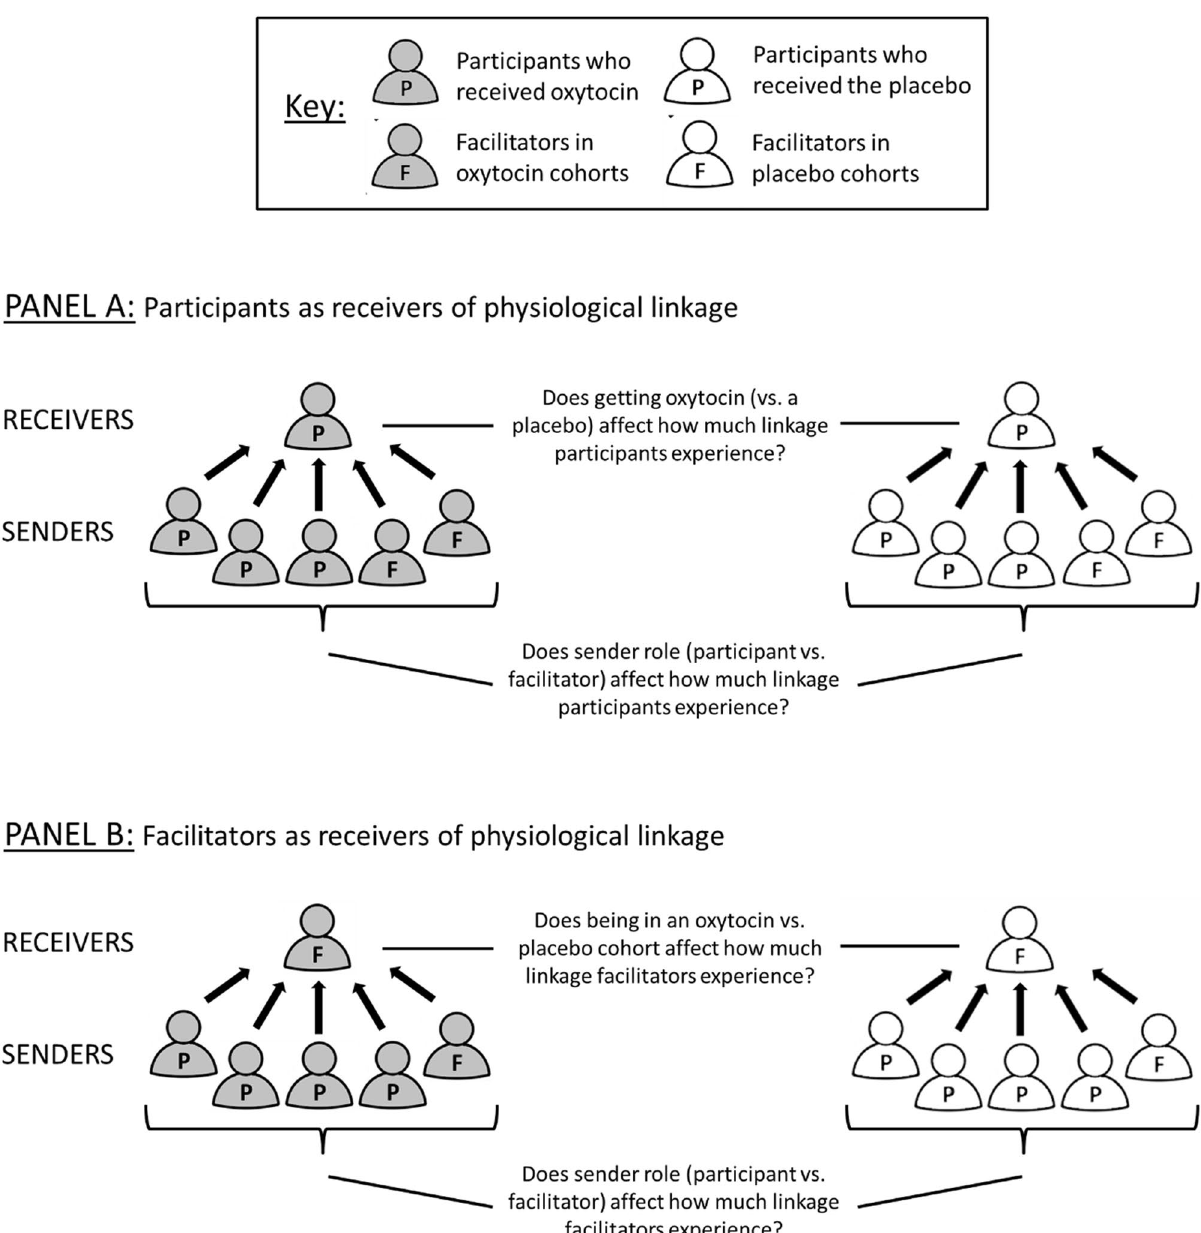
Figure 3. Models of physiological linkage. Arrows indicate potential physiological linkage from senders to receivers: senders’ physiological responses predict the physiological responses of receivers at a following time interval. ( A ) We examine how much participants are receivers of physiological linkage (i.e., how much other people’s physiological responses predict participants’ physiological responses) based on the drug they received and the role of senders. ( B ) We examine how much facilitators are receivers of physiological linkage (i.e., how much other people’s physiological responses predict facilitators’ physiological responses) based on the drug that participants in their cohort received and the role of